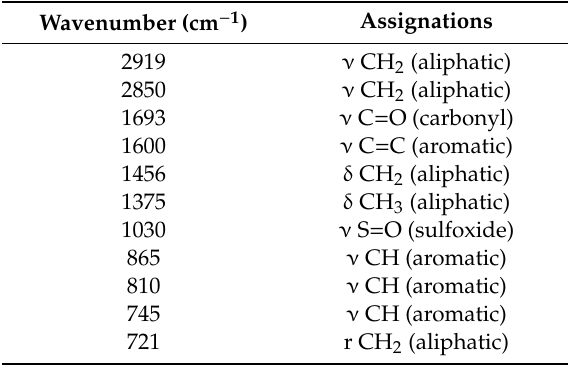
Table 6. Summary of the main bands and respective